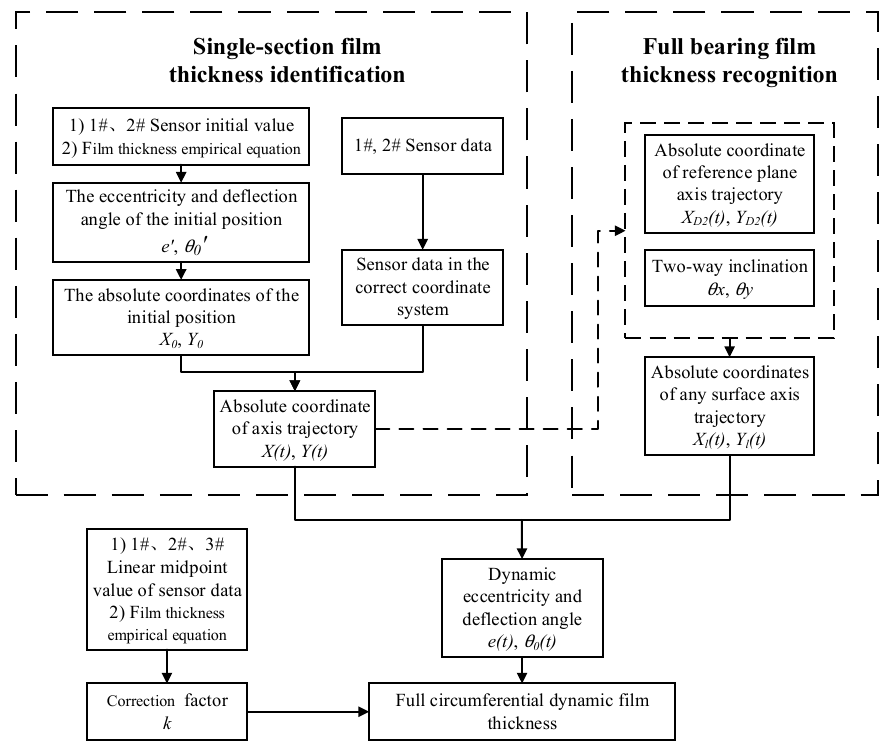
Figure 5. Flow chart of the full-circumference film-thickness identification method. The initial position of the shaft center measured at the time of stable bearing operation is selected as the reference point. According to the empirical equation of film thickness, the following relationship exists between sensor data and film thickness at the initial moment.